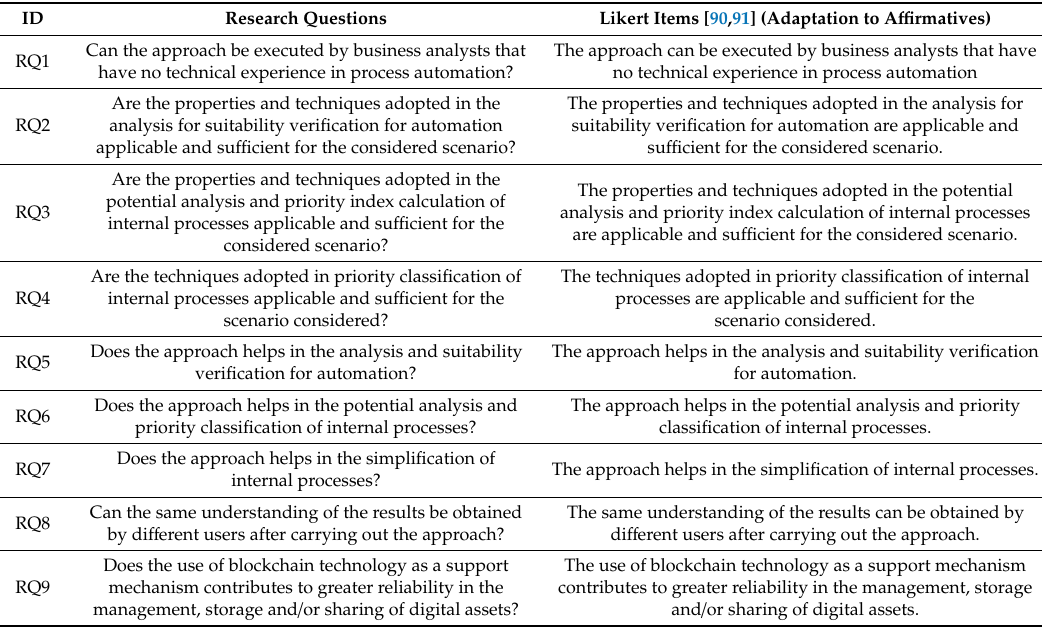
Figure 12. Process for the definition and application of the research. Table 10. Research questions for the survey.